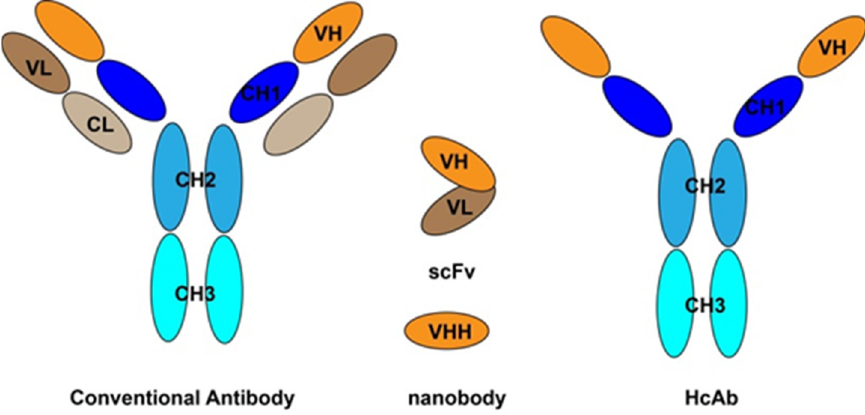
Figure 3. Different types of recombinant antibodies compared with conventional antibody.